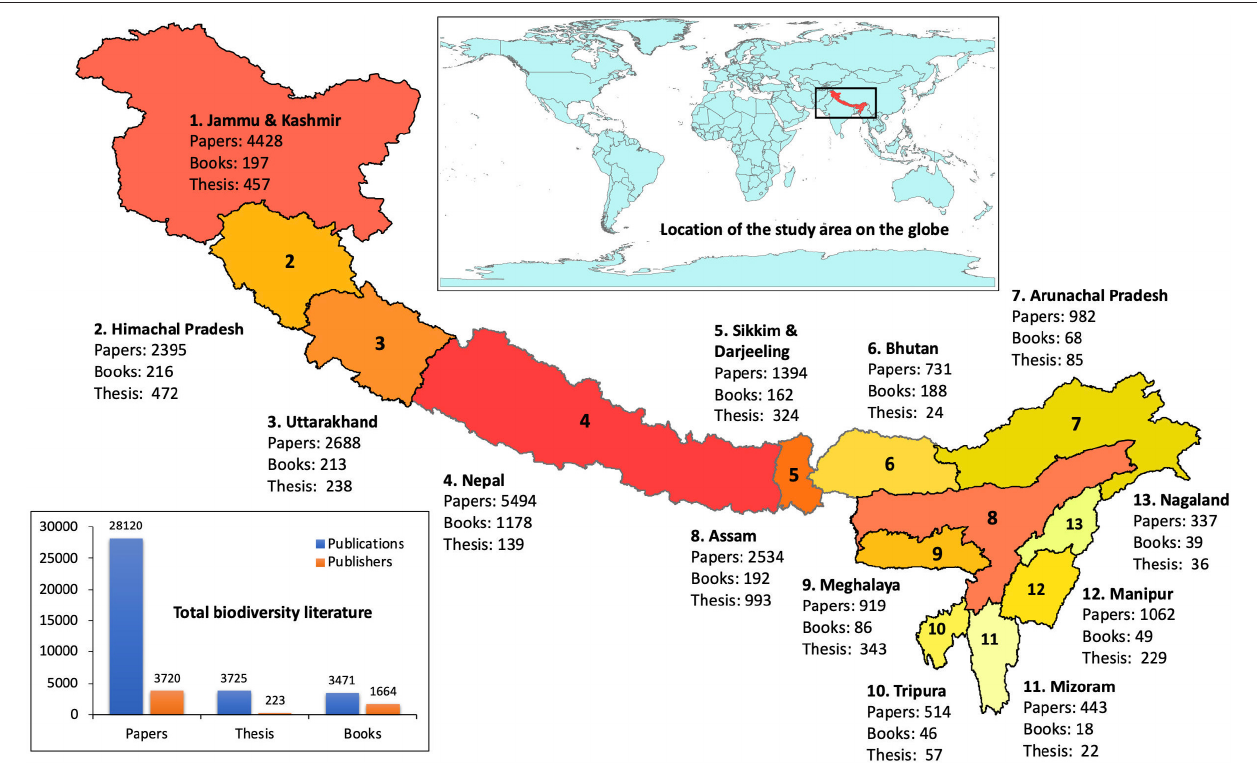
FIGURE 2 | The study region (i.e., 11 Indian Himalayan and northeastern states, Nepal, and Bhutan) exhibiting the number of research publications identified on biodiversity from 1808 to 2018. The upper panel shows the location of the study region on the globe, and the lower panel shows totals of journal articles, theses, and books with the respective publishers, including journals, universities, and book